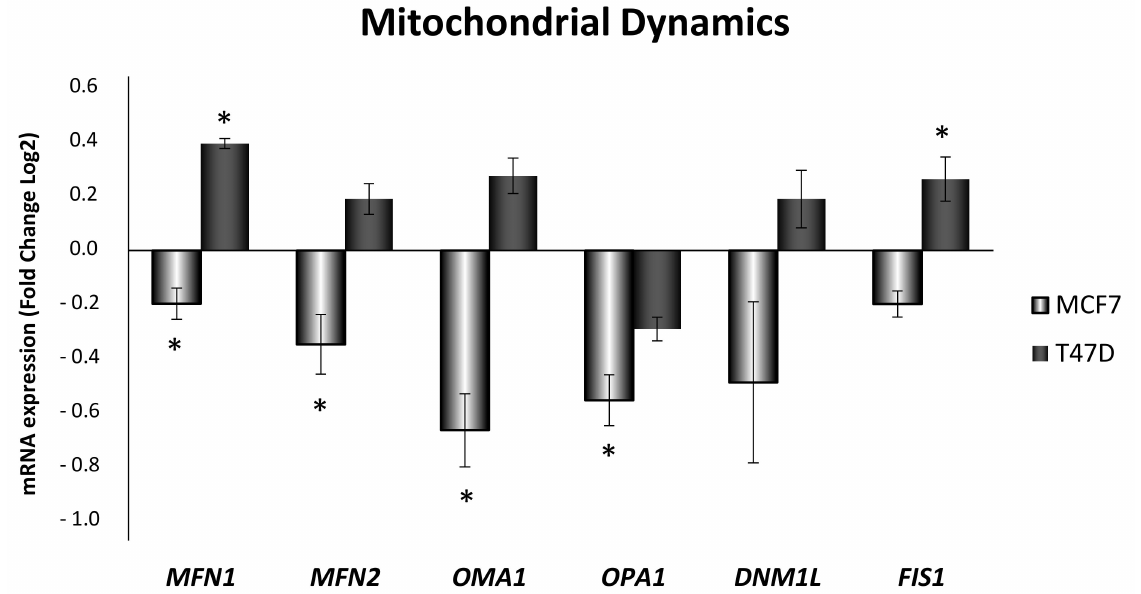
Figure 5. Obesity-related inflammation treatment modified expression of genes related to mitochondrial dynamics in MCF7 and T47D breast cancer cell lines. MFN1 : mitofusin-1; MFN2 : mitofusin-2; OPA1 : mitochondrial dynamin-like GTPase; OMA1 : zinc metallopeptidase; DNM1L : dynamin 1 like; FIS1 : mitochondrial fission 1 protein. Breast cancer cells were incubated for 24 h with vehicle (DMSO) or ELIT. Data are represented as fold change (log2) of mRNA expression with respect to vehicle-treated cells, set at 0, of each cell line. Data represent means ± SEM ( n = 6). * Statistically significant difference between treated and vehicle-treated cells (Student’s t -test, * p <